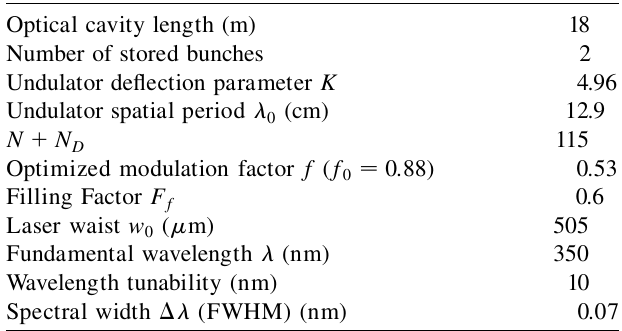
TABLE II. Main Super-ACO FEL characteristics.